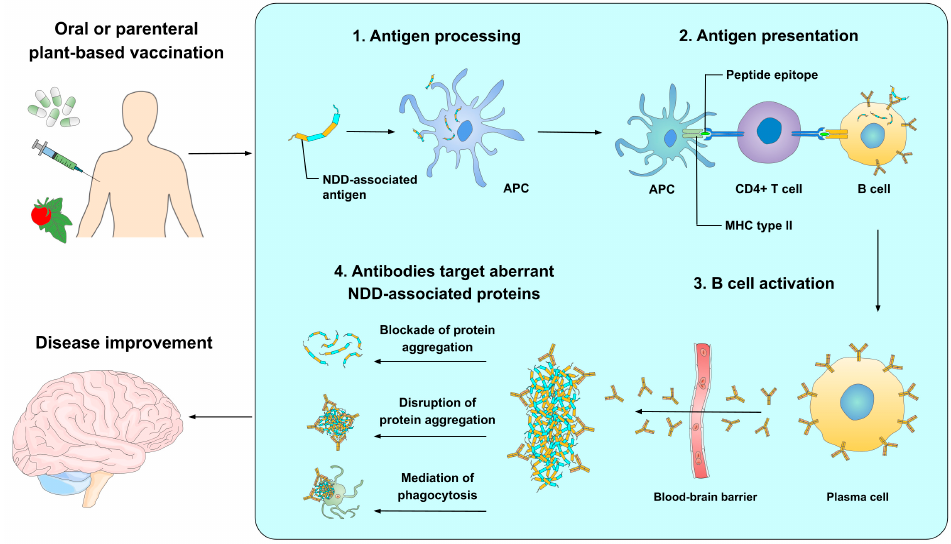
Figure 2. Mechanism of action of peptide-based vaccines against NDDs. Following oral or parental vaccination, APCs use PRRs to identify foreign antigens; these are internalized and processed by the proteasome to be expressed on the cell surface as peptide epitopes in the MHC type II. Afterward, CD4+ T cells interact with APCs, prompting the activation of B cells. As a result, plasma cells (active B cells) produce highly specific antibodies against the NDD-related epitope. Antibodies move through the blood circulation and pass the blood-brain barrier to reach the CNS, where they bind to the NDD-associated proteins in order to eliminate them or impede their functions.